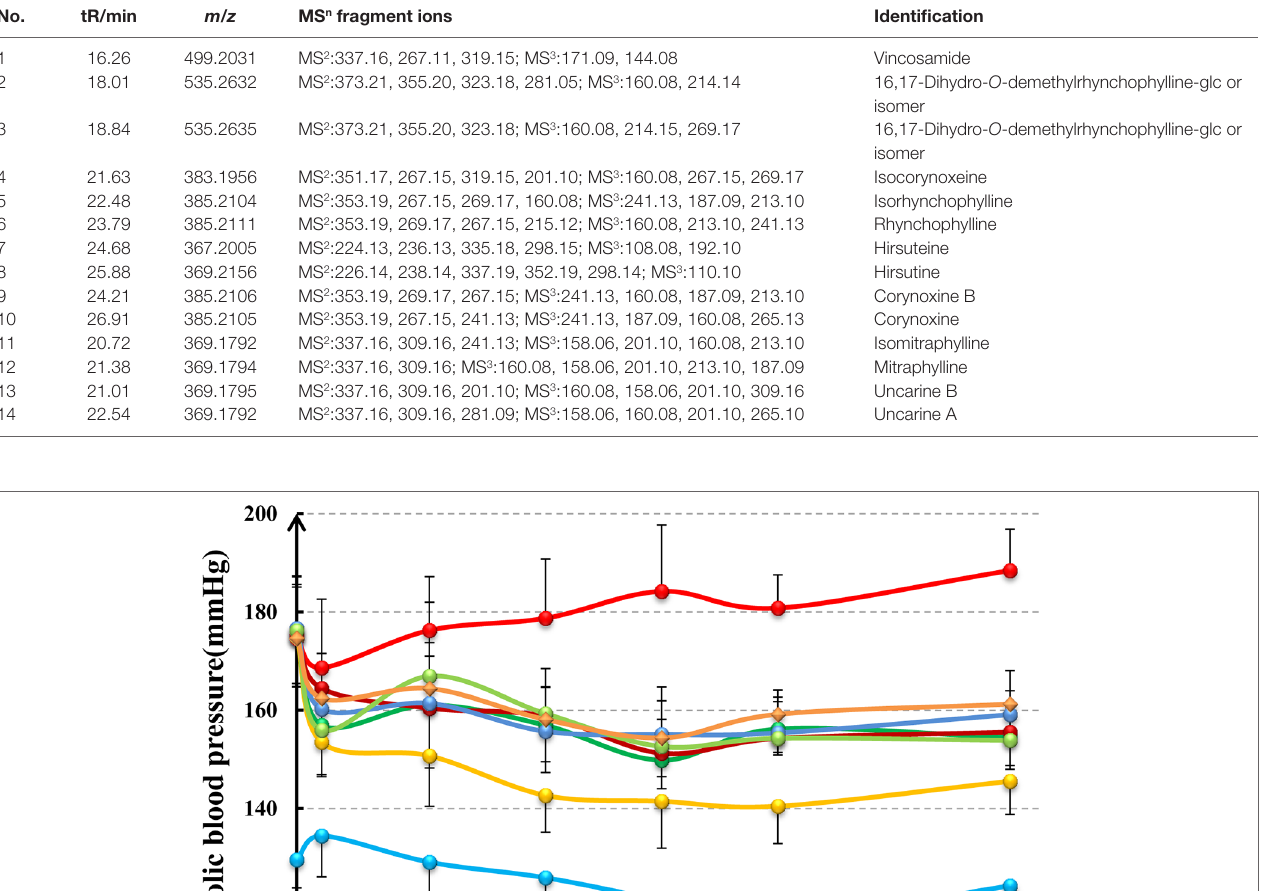
TABLE 1 | U-HPLC/LTQ-Orbitrap analysis of the aqueous extract of the Uncaria Stem with Hooks (UHs). No.